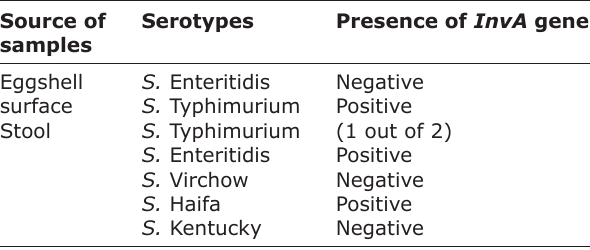
Table-4: Detection of invA gene from the positive serotyping.